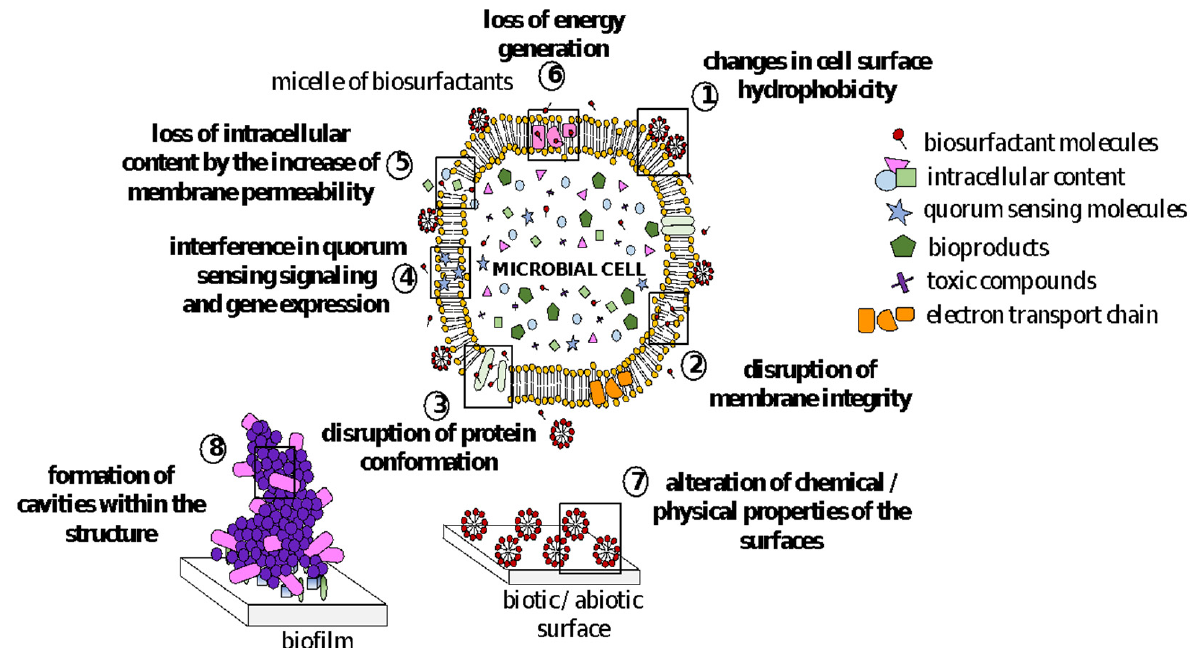
Figure 2. Mechanisms of action of biosurfactants against microbial cell membranes and biofilms.